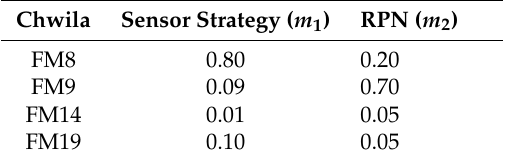
Table 3. The Dempster-Shafer (DS) evidence theory analysis of the fuzzy FMEA of